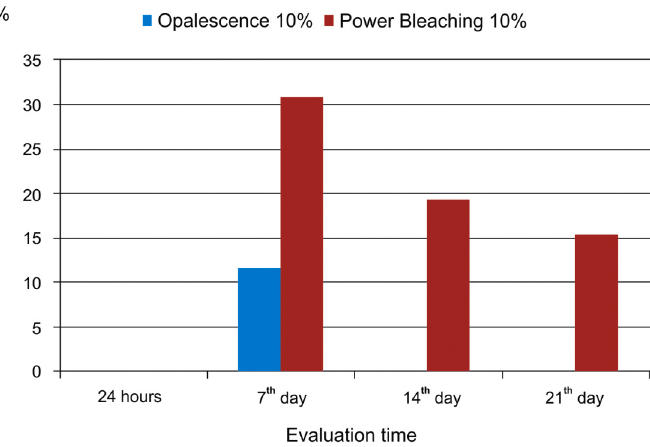
Figure 6- Volunteers (%) presenting gingival irritation during the bleaching treatment, according to the study periods and bleaching